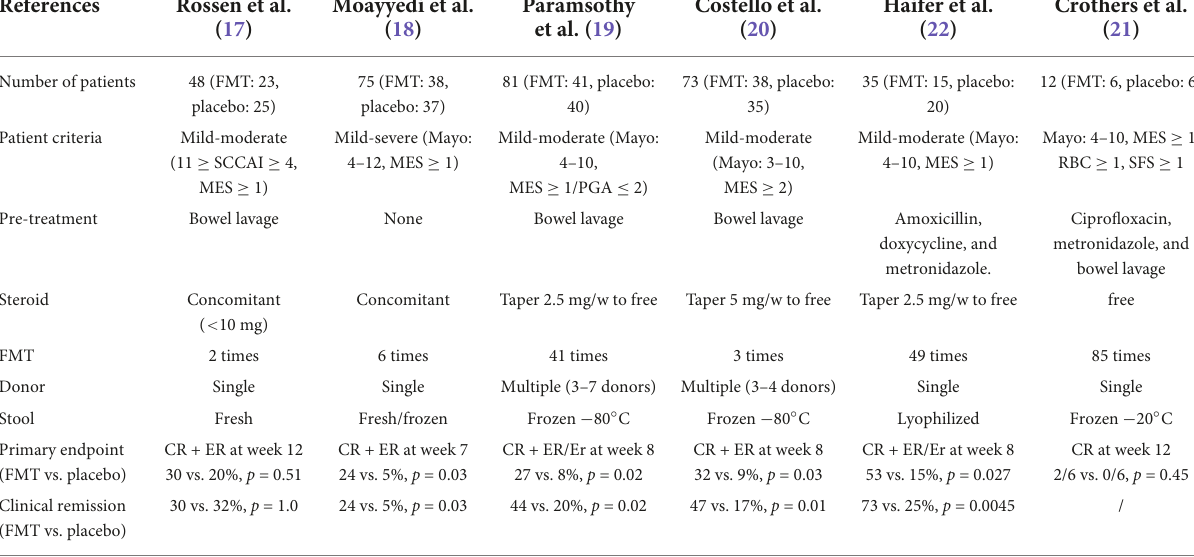
TABLE 1 Efficacy of FMT on UC patients with six double-blind, randomized controlled